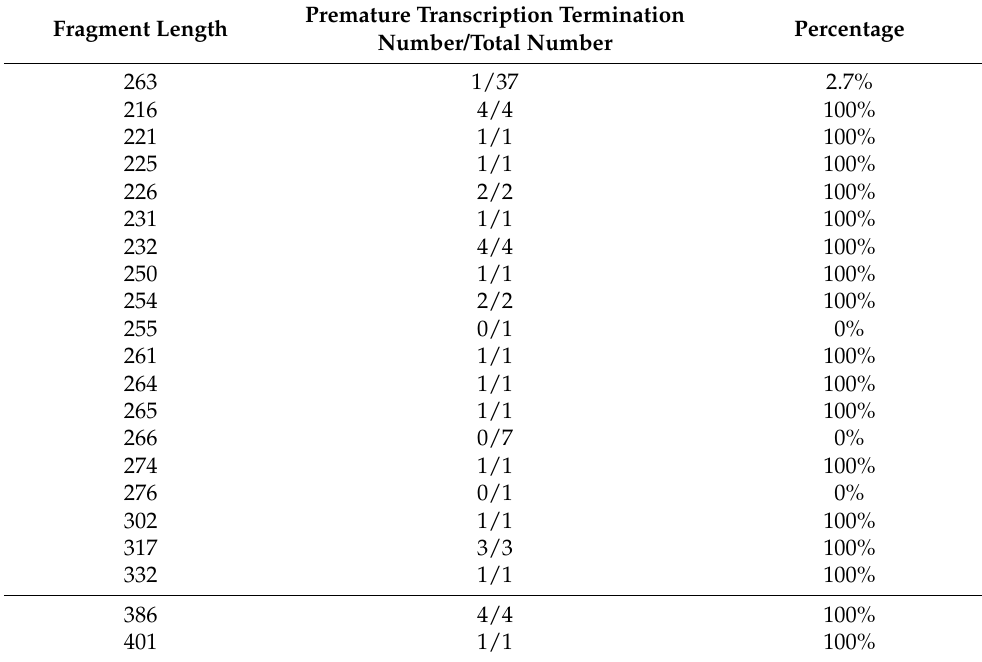
Table 1. Analysis of sequence premature transcription termination and the fragment length of